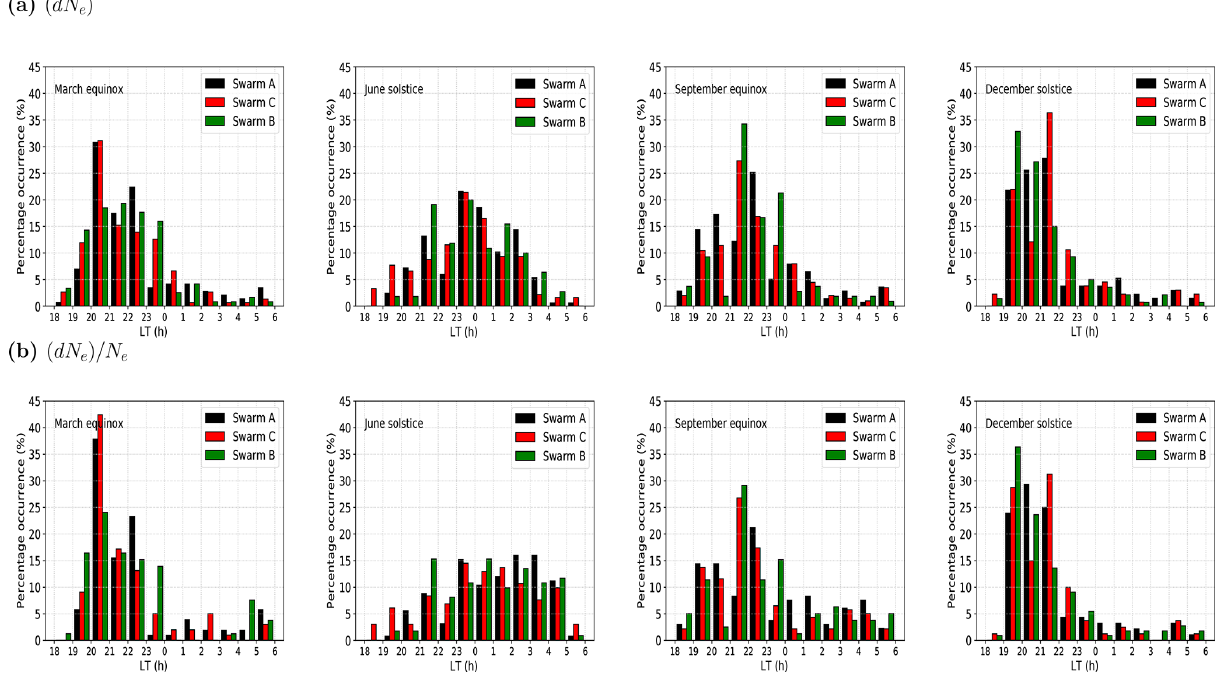
Figure 3. Histograms showing the percentage occurrence of (a) dN e > 0 . 25 × 10 10 m − 3 and (b) dN e /N e > 0 . 01 as a function of local time (LT) for the period from October 2014 to October 2018 for Swarm A, B and C. Each panel presents a